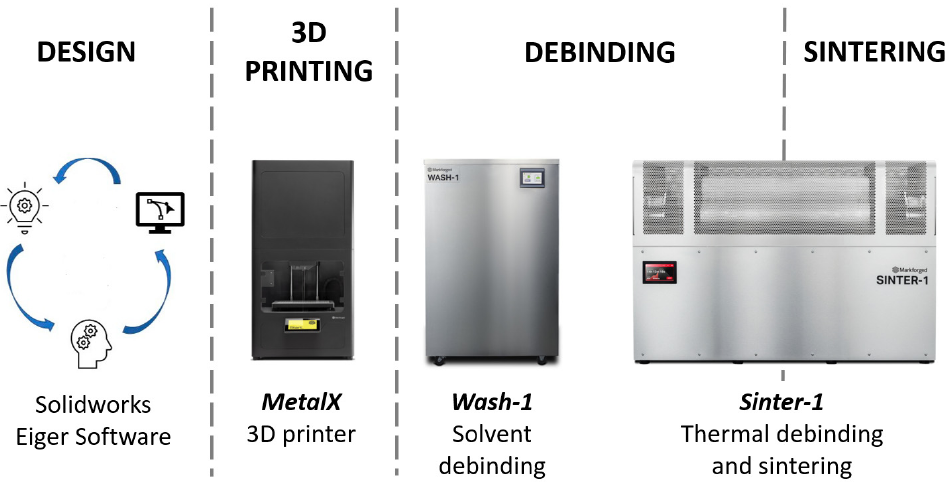
Figure 2. Flow chart of the manufacturing process of copper parts with Metal Extrusion Additive Manufacturing technique using the Markforged equipment.